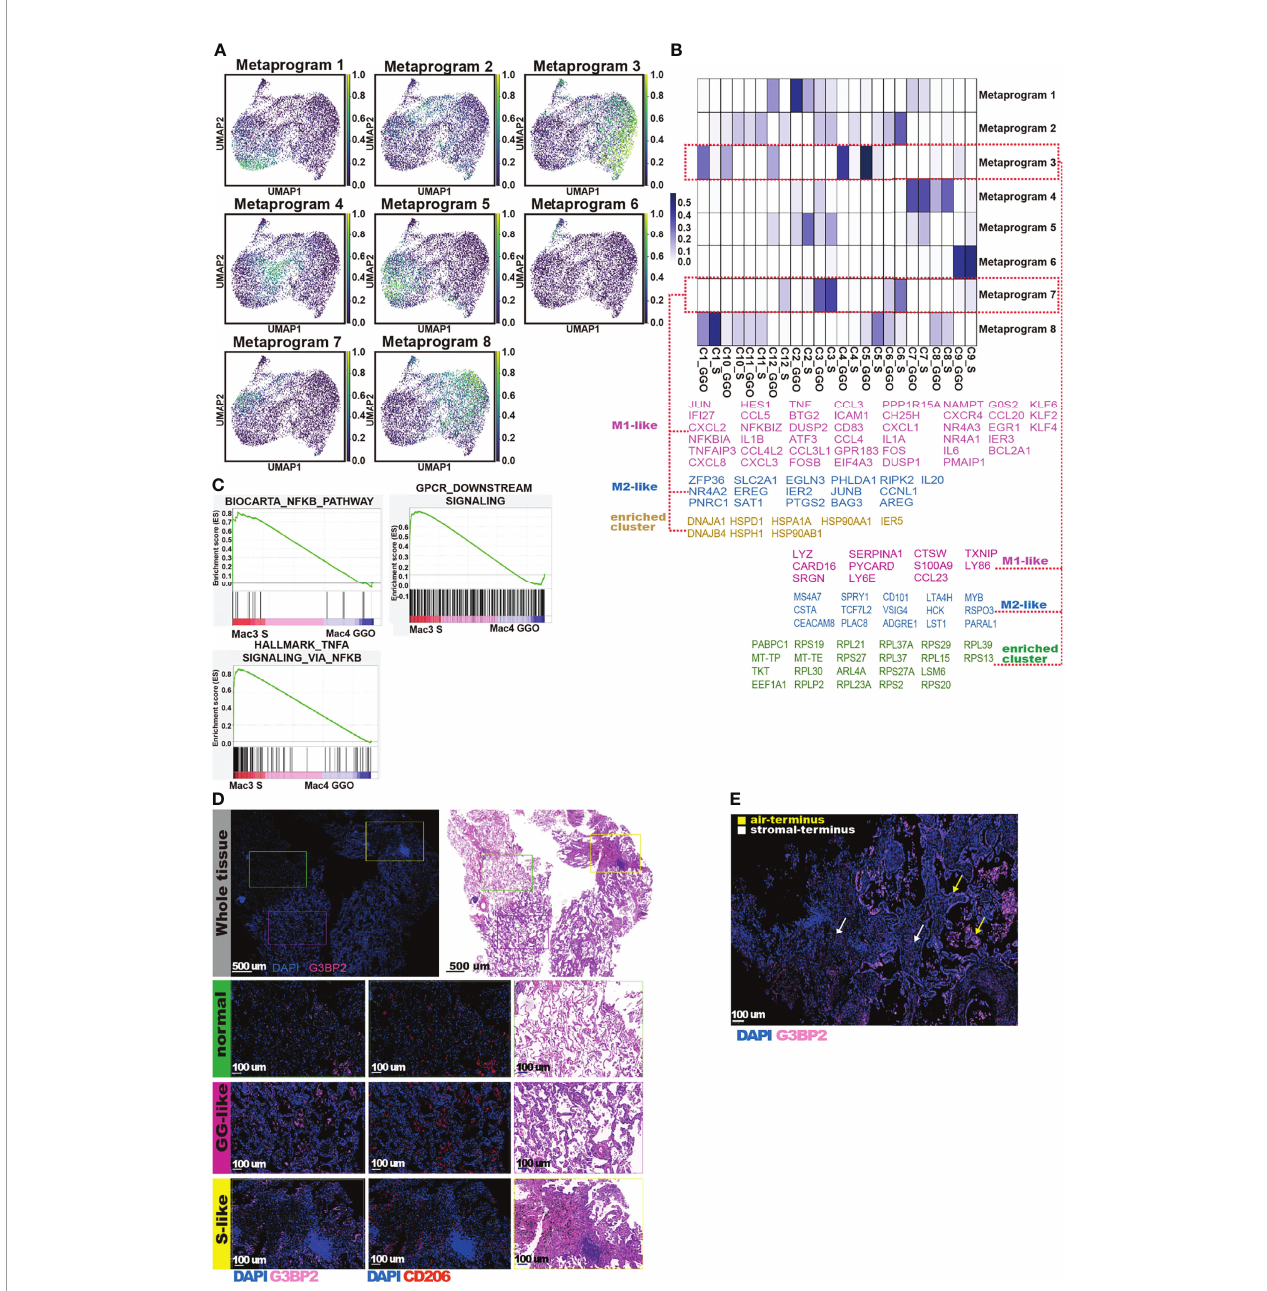
FIGURE 6 | cNMFandIFArevealdifferentsignaturesofmacrophagesbetweenGGcomponentandScomponent. (A) TheUMAPshowsmeta-programofmacrophagegenes clusteredbythecNMF;theshadesofthecolorsrepresentproportionsofcellsexpressingthemeta-program. (B) Theheatmaprevealstheexpressionlevelofmeta-program (row)ineachsample(row);GGdominantmeta-program(up)andSdominantmeta-program(down)aremarkedwithredboxes.WealsolistM1-likegenes,M2-likegenes,and enrichedgenesetswithsimilarfunctionsineachhighlightedmeta-program. (C) TheGSEAusingpre-rankeddifferentiallyexpressedgenesbetweenMac3_Scomponentand Mac4_GGcomponentwerecomparedwithhallmarkgenesets,Biocartagenesets,andGPCRgenesets.Thepre-rankedgenesetwasde fi nedbyfunctionoftheFindMarkers inSeurat.WeshowtheenrichmentofNF- k Bpathway(topleft),NF- k B-initiatedTNF-alphasignalingpathway(bottomleft),andGPCRpathway(right). (D) G3BP2expressionin nlung,GG-like,andS-liketissue.The “ WholeTissue ” panelshowstheoverallregionofan “ mGGOlooking ” areawithIFAandH&Estains.Atypical fi eldofnlung,GG-like,and S-likewasselectedusinggreen,pink,andyellowboxes,respectively.Scalebars,500 m m.Thezoomed-inversionofeach fi eldisbelowthepanels(row).Eachpanel,fromleftto right,showstheimageofDAPI(blue)+G3BP2(pink),DAPI(blue)+CD206(red),andH&Estains.Scalebars,100 m m. (E) IFAshowsthehighexpressionlevelofG3BP2(red)in lepidicgrowthcancercellsandmacrophagesinthealveolarcavity(yellowarrow)comparedwiththosein fi ltratedintostromalcells(whitearrow).cNMF,couplednon-negative matrixfactorization;IFA,immuno fl uorescenceassay;GG,groundglass;S,solid;UMAP,UniformManifoldApproximationandProjection;GSEA,geneset